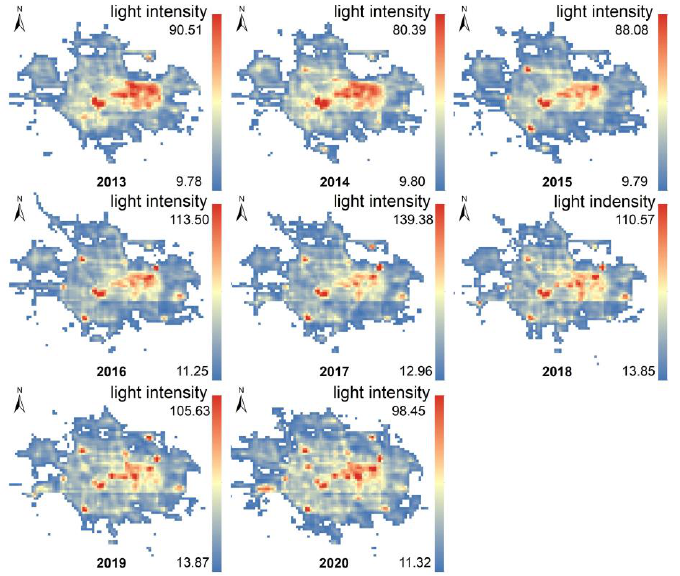
Figure 2. The light intensity of the built-up area of Zhengzhou city masked by light intensity thresh- olds from 2013 to